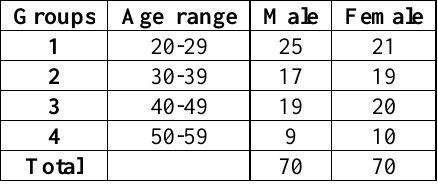
Table 1: Distribution of participating patients according to age and